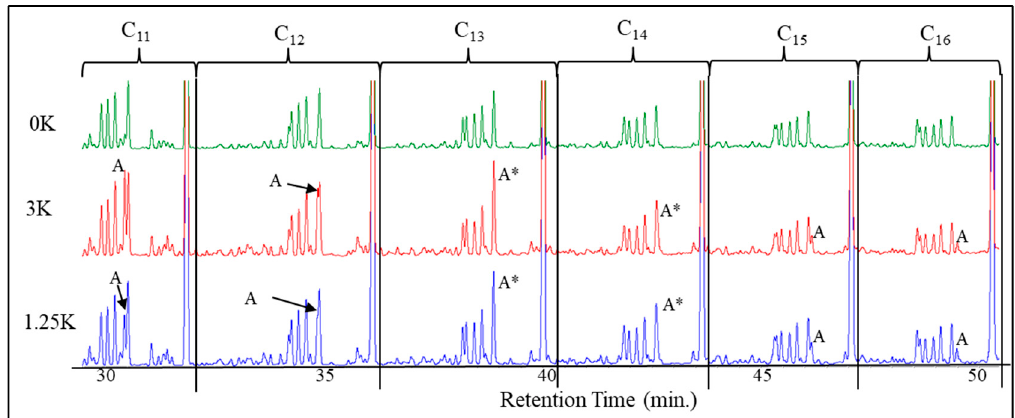
Figure 9. A chromatographic picture comparing different branching materials of specific carbon materials for a 0 K (i.e., no potassium promoter) active iron catalyst. This represents mixed oils from several iron runs where the oils were exposed to H 2 at 0.68 bar for 5 min using Pt/C catalyst converting all olefinic materials to alkanes. All runs at 230 °C, 12.1 bar, 0.7 H 2 /CO with a WHSV = 2.